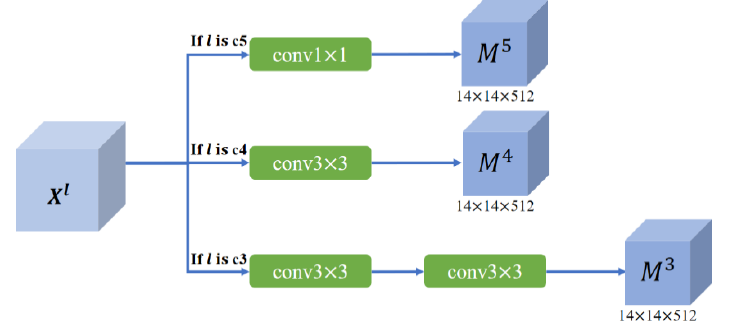
Figure 4. The resize operation for different level layer.